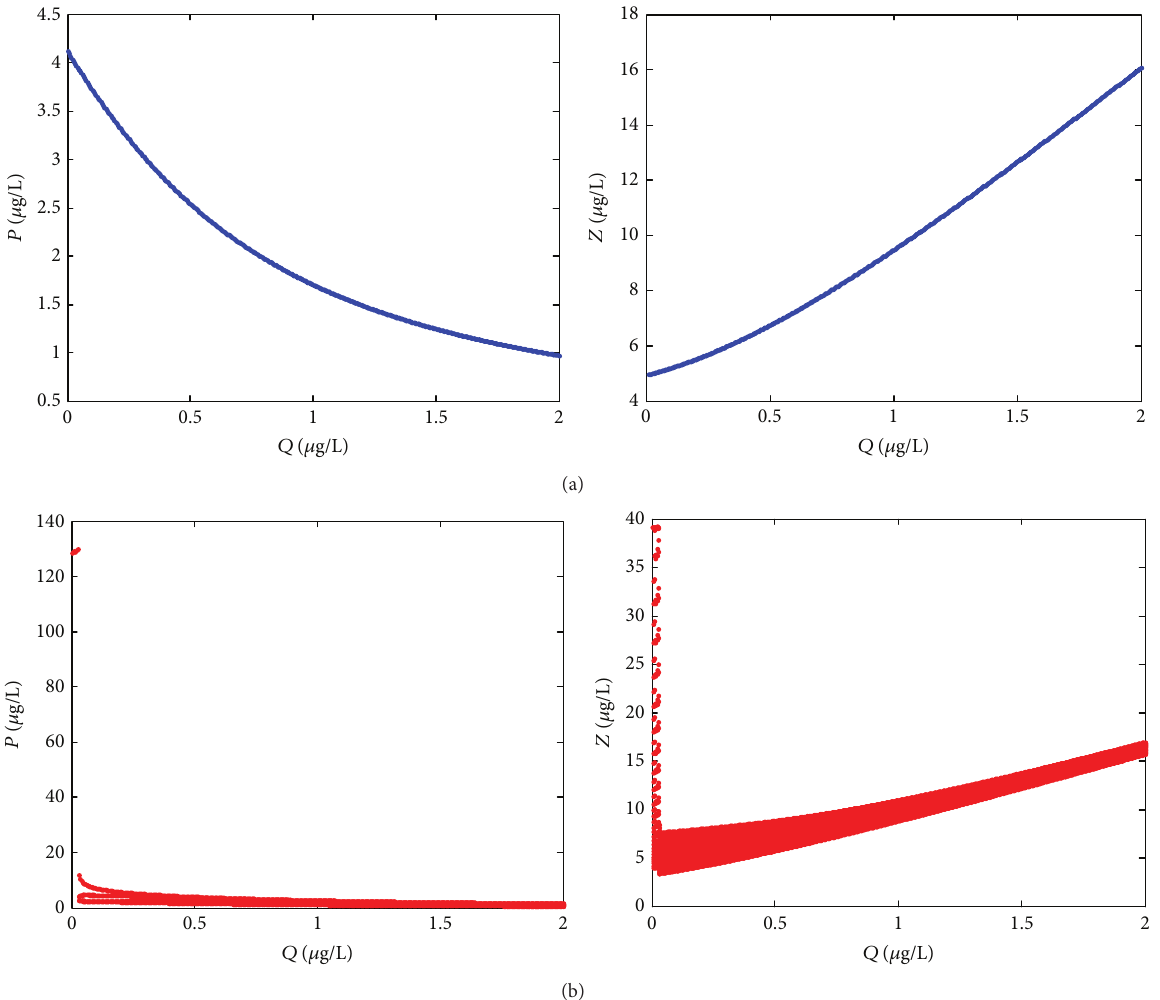
Figure 2: Bifurcation diagrams of system (3) without (a) and with (b) seasonally varying phytoplankton growth rate when 0 ≤ 𝑄 ≤ 2